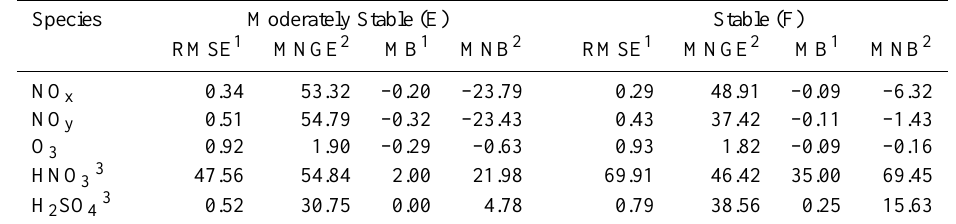
Table 3. Statistical analysis with observed and model-predicted plume concentrations at eight